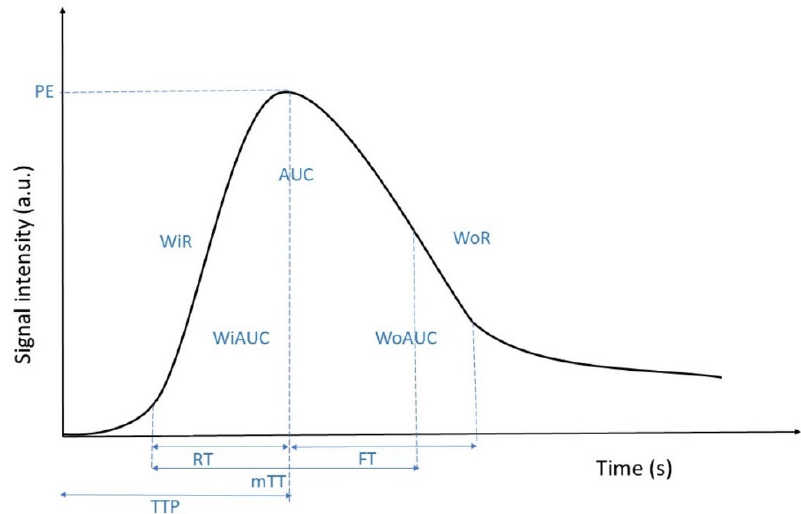
Figure 1. Illustration of the position of the regions ‐ of ‐ interest on a contrast ‐ enhanced ultrasound image of a healthy cat’s kidney. Cortex regions ‐ of ‐ interest are enclosed by a white striped line, me ‐ dulla regions ‐ of ‐ interest by a white dotted line, and the region ‐ of ‐ interest surrounding the interlo ‐ bar artery by a solid white line.